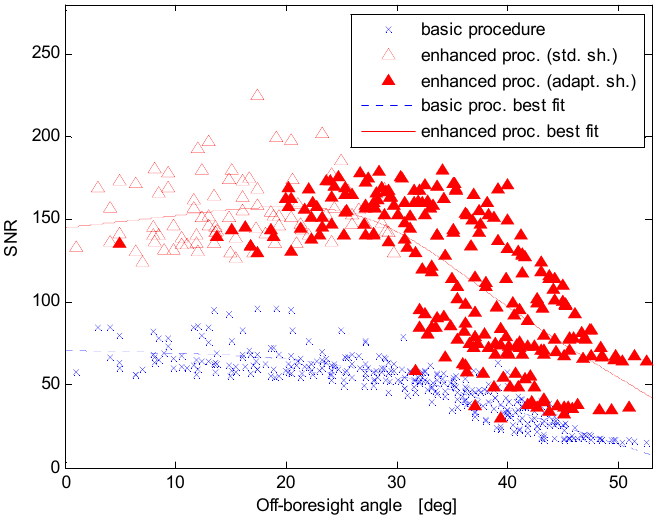
Figure 5. SNR versus the off-boresight angle for the basic and enhanced procedures.